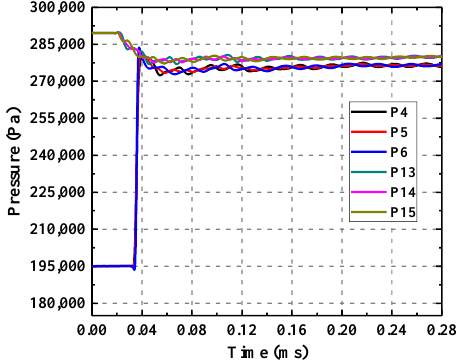
Figure 19. Pressure-time curves of the monitor points perpendicular to the passage